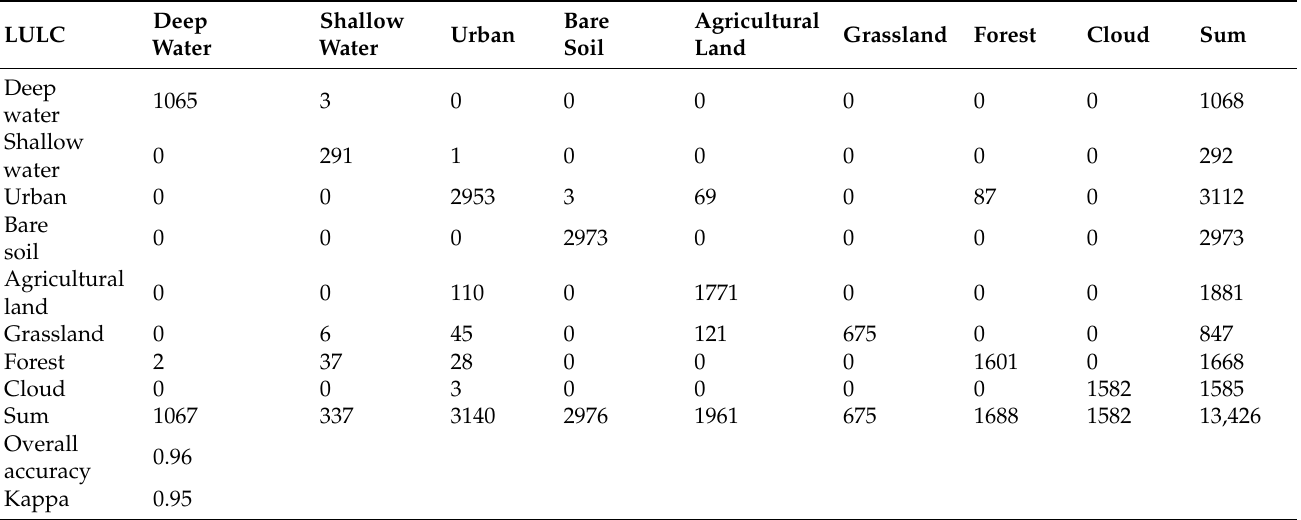
Table 10. Error matrix for accuracy assessment of LULC classification using artificial neural network (Leeuwen et al. [48]).